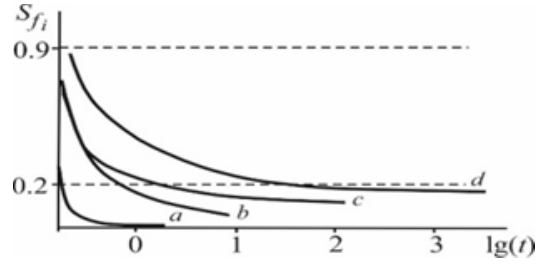
Figure 2. Characteristic curves for some